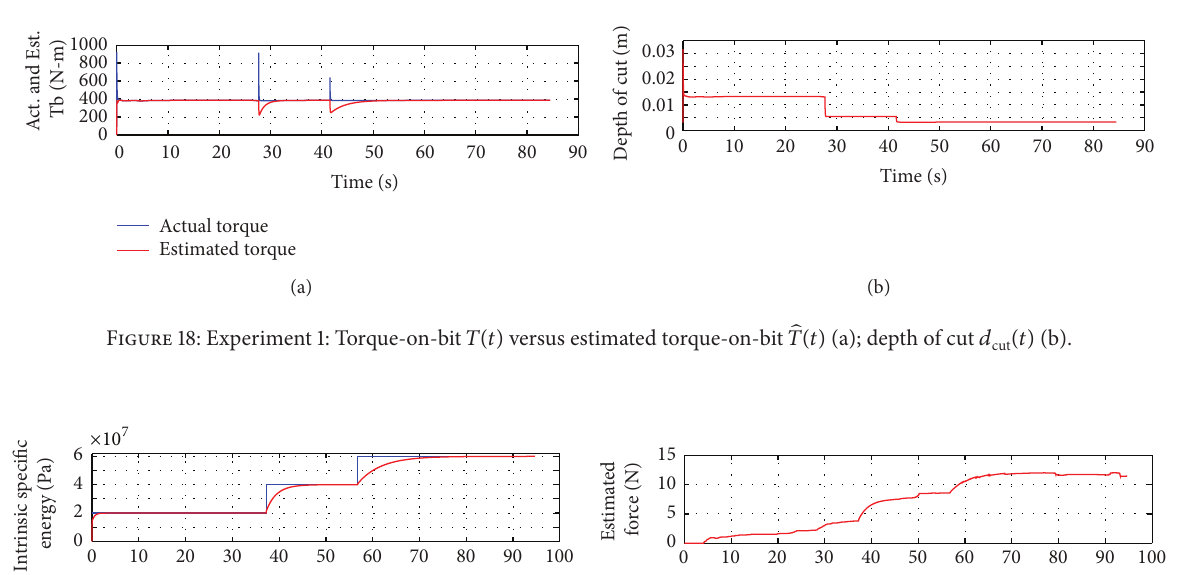
Figure 19: Experiment 2: Actual stiffness 𝜖(𝑡) versus estimated stiffness ̂𝜖(𝑡) (a); reflected force 𝐹